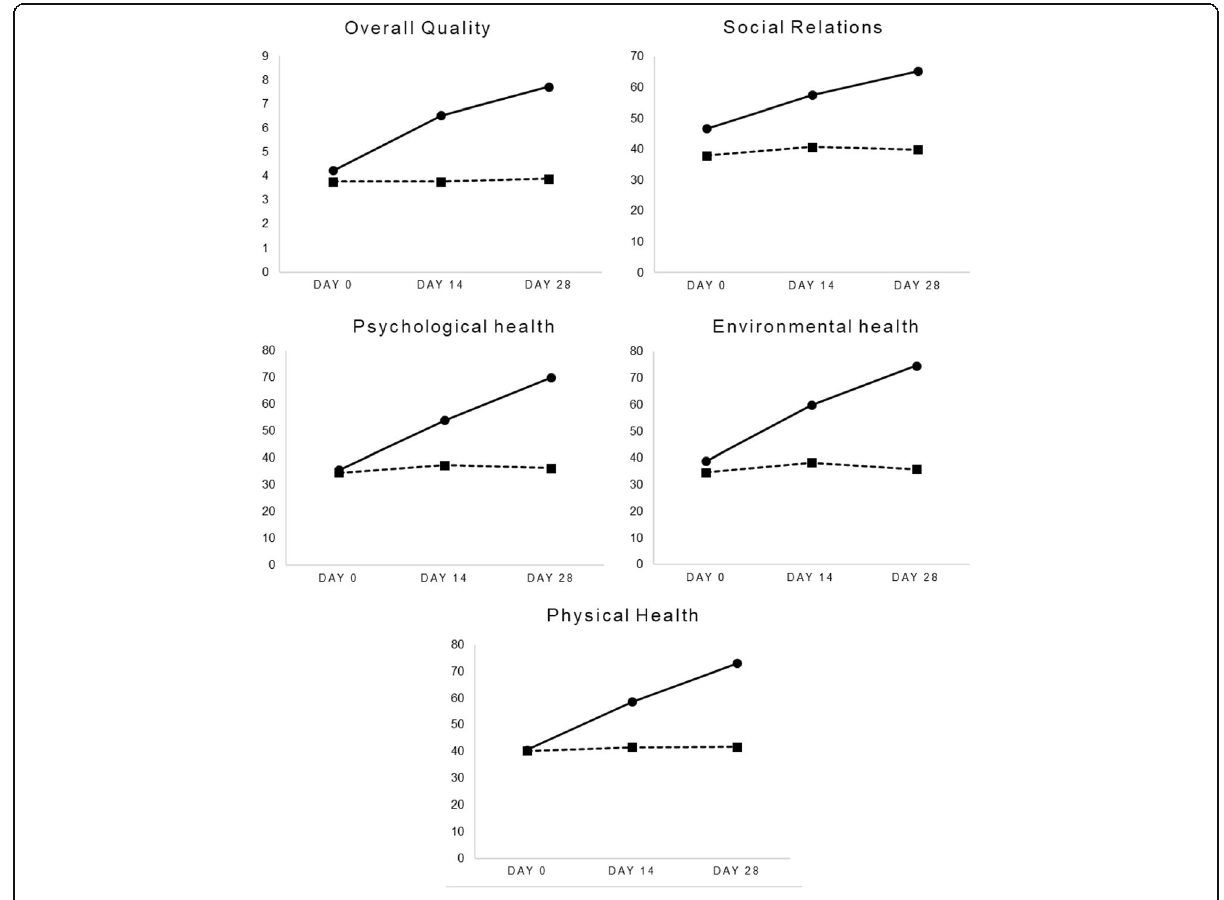
Fig. 3 WHOQOL-BREF domain ratings over